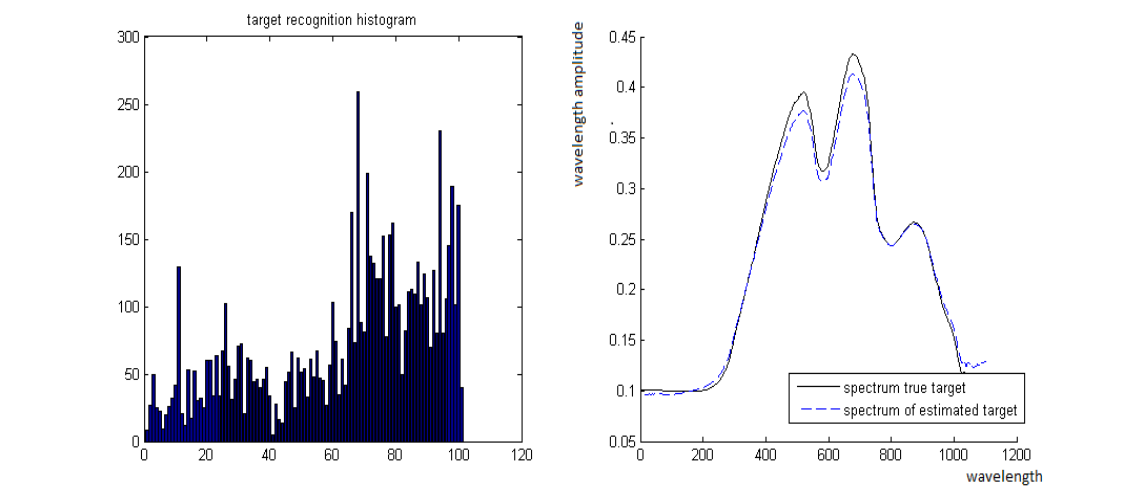
Case 3. True value is t = 0.49 where its estimate is ˆ t =